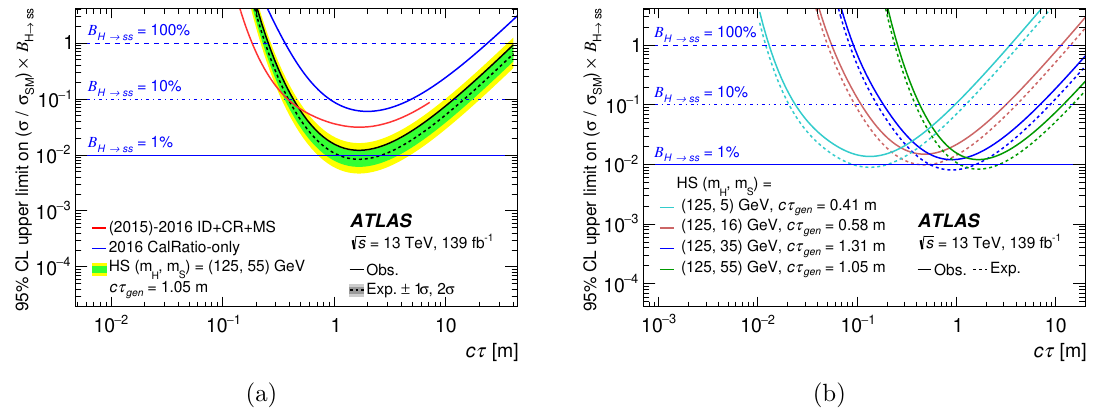
Figure 10. (a) 95% CL expected and observed limits on the BR of SM Higgs bosons to pairs of neutral LLPs ( B H → ss ), showing the ± 1 σ (green) and ± 2 σ (yellow) expected limit bands, as well as a comparison with the results from previous ATLAS searches [36, 37], and (b) summary of 95% CL expected and observed limits on the BR of a SM Higgs boson mediator to pairs of neutral LLPs considered in this analysis. The cross-section for SM Higgs boson gluon-gluon fusion production is assumed to be 48 . 6 pb.